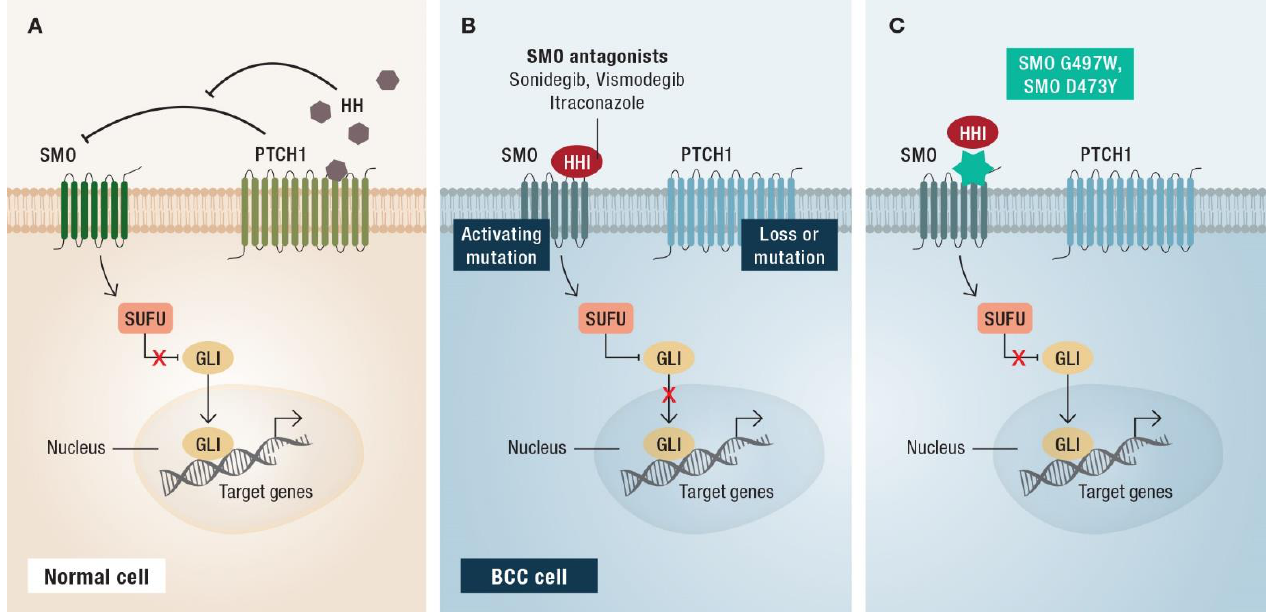
Figure 1. Schematic representation of the Hedgehog (HH) signaling pathway. ( A ) Binding of the extracellular HH ligand to the Patched 1 (PTCH1) receptor releases Smoothened (SMO) from inhibition. SMO starts an intracellular signaling cascade including Suppressor of Fused (SUFU), which results in activation of the transcription factors of the GLI family; ( B ) loss-of-function mutations in PTCH1 or activating mutations in SMO activate the HH signaling pathway in basal cell carcinoma (BCC) cells. This process can be inhibited by HH pathway inhibitors (HHI); ( C ) intrinsic resistance as caused by SMO G497W mutation, or acquired resistance as caused by SMO D473Y mutation impede entry of the drug into the binding site. Modified according to [1].